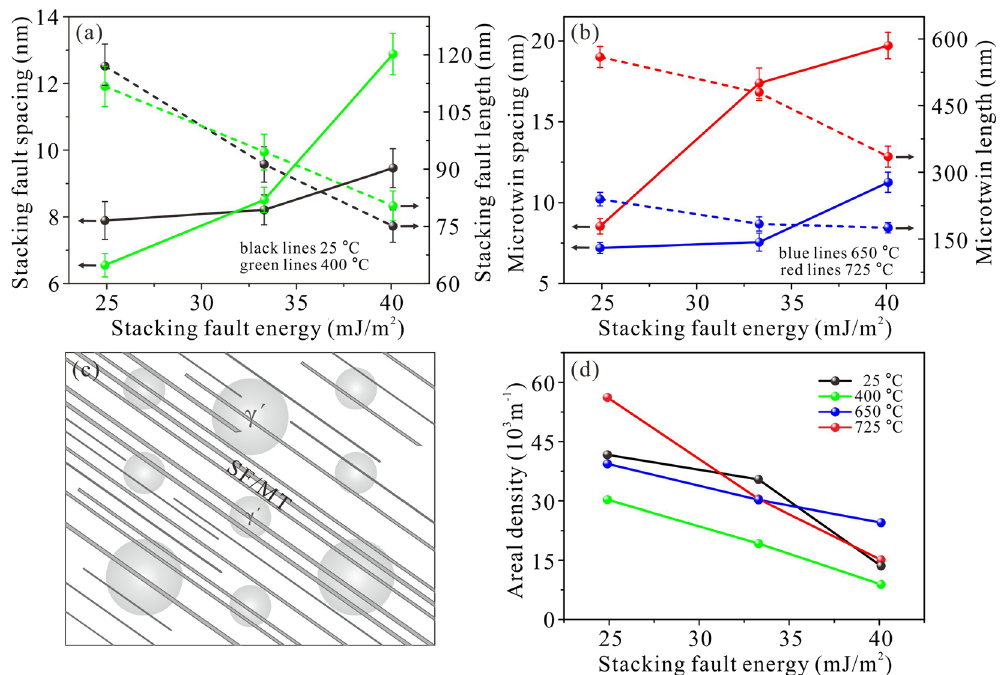
Figure 5. Statistical results on the size and distribution of SF and MT in the three superalloys with different SFE. ( a ) The variation of SF spacing and length with SFE; ( b ) the variation of MT spacing and length with SFE; ( c ) sketch map for calculating the areal density of SF and MT; ( d ) the changes of SF/MT areal density with SFE. 5Co: 40.1 mJ/m 2 ; 15Co: 33.3 mJ/m 2 ; 23Co: 24.9 mJ/m 2